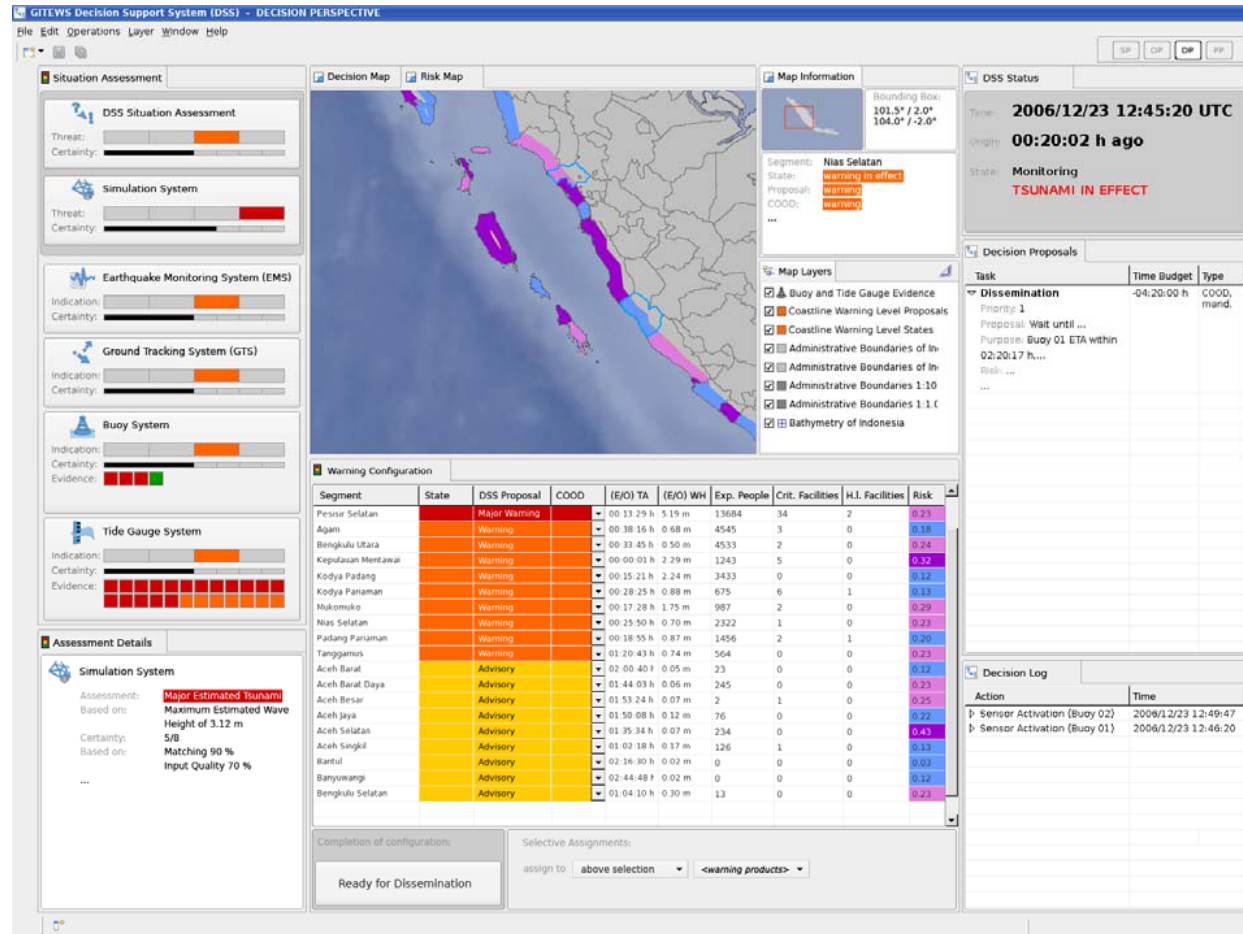
Fig. 9. Integration of tsunami risk parameters in the Decision Support